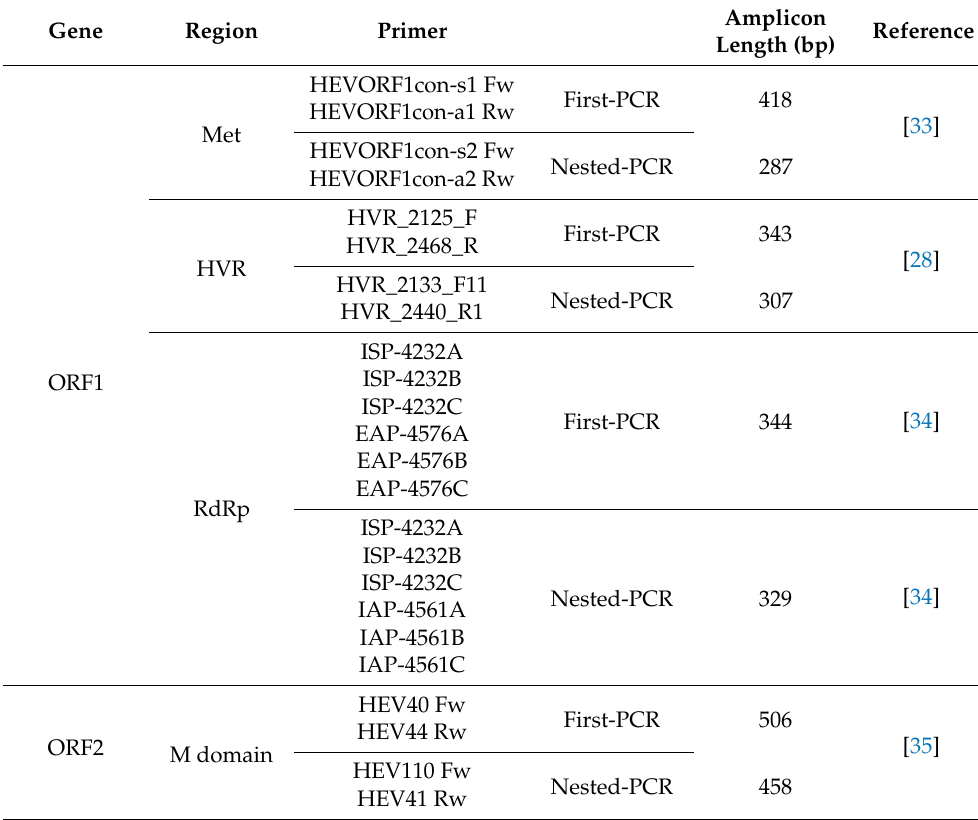
Table 1. Primers and genome regions amplified by